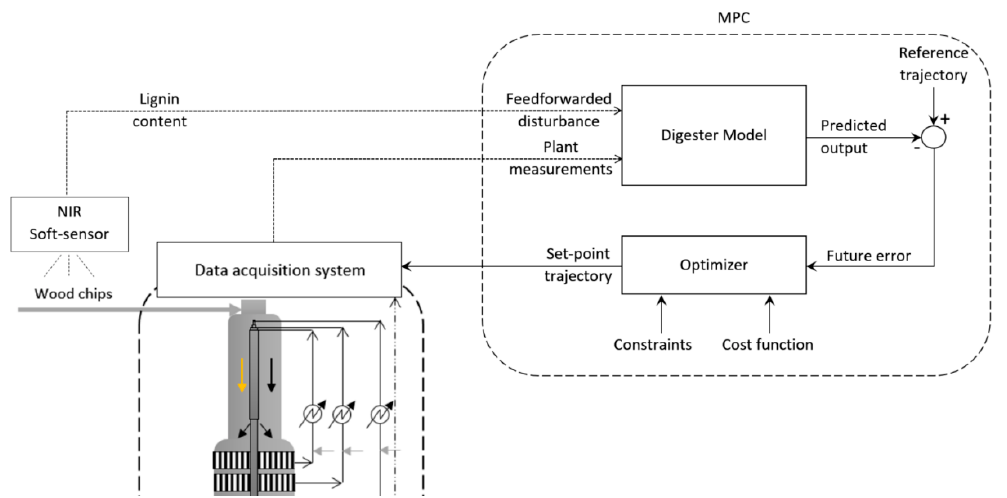
Figure 7. Scheme of feedforward model predictive control (MPC) for continuous pulp digester.